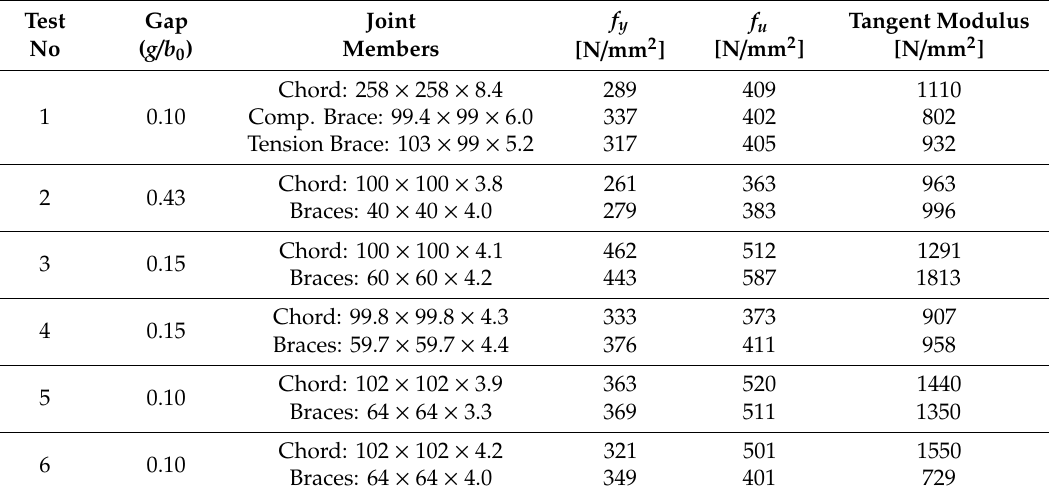
Table 1. RHS members in tests and material properties